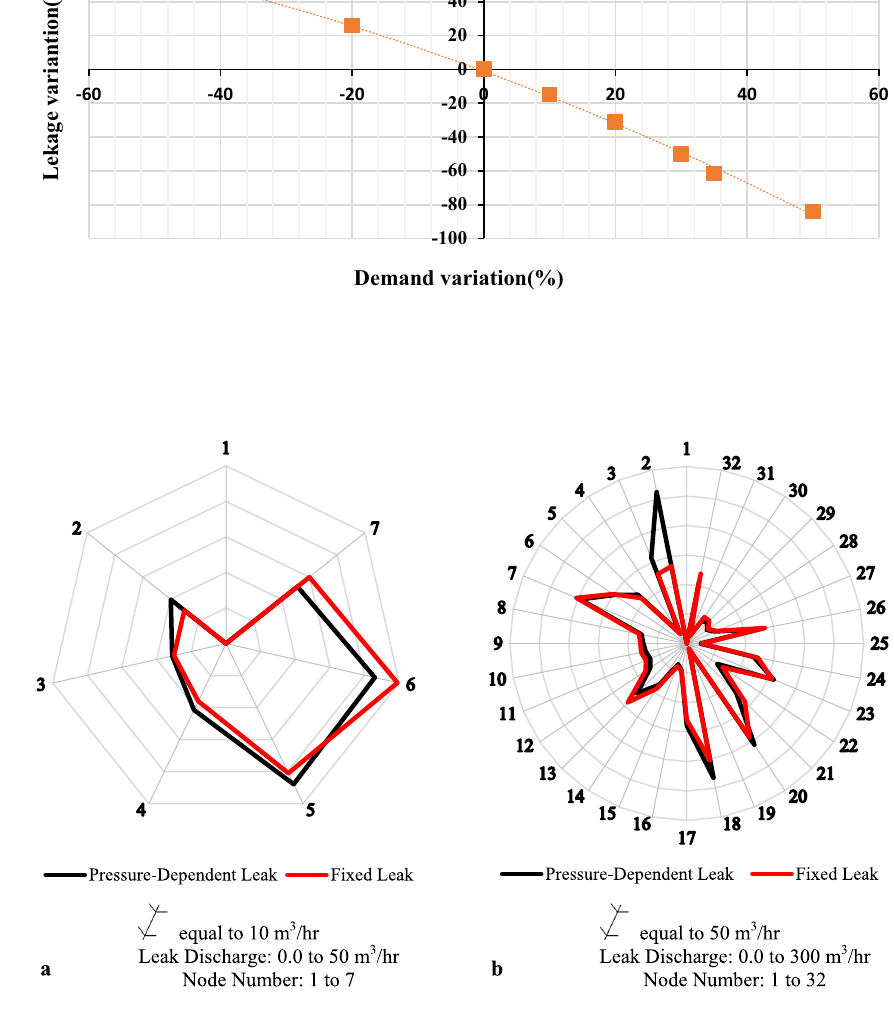
Fig. 10 Variation in network total leakage versus total demand variation for three-loop WDN